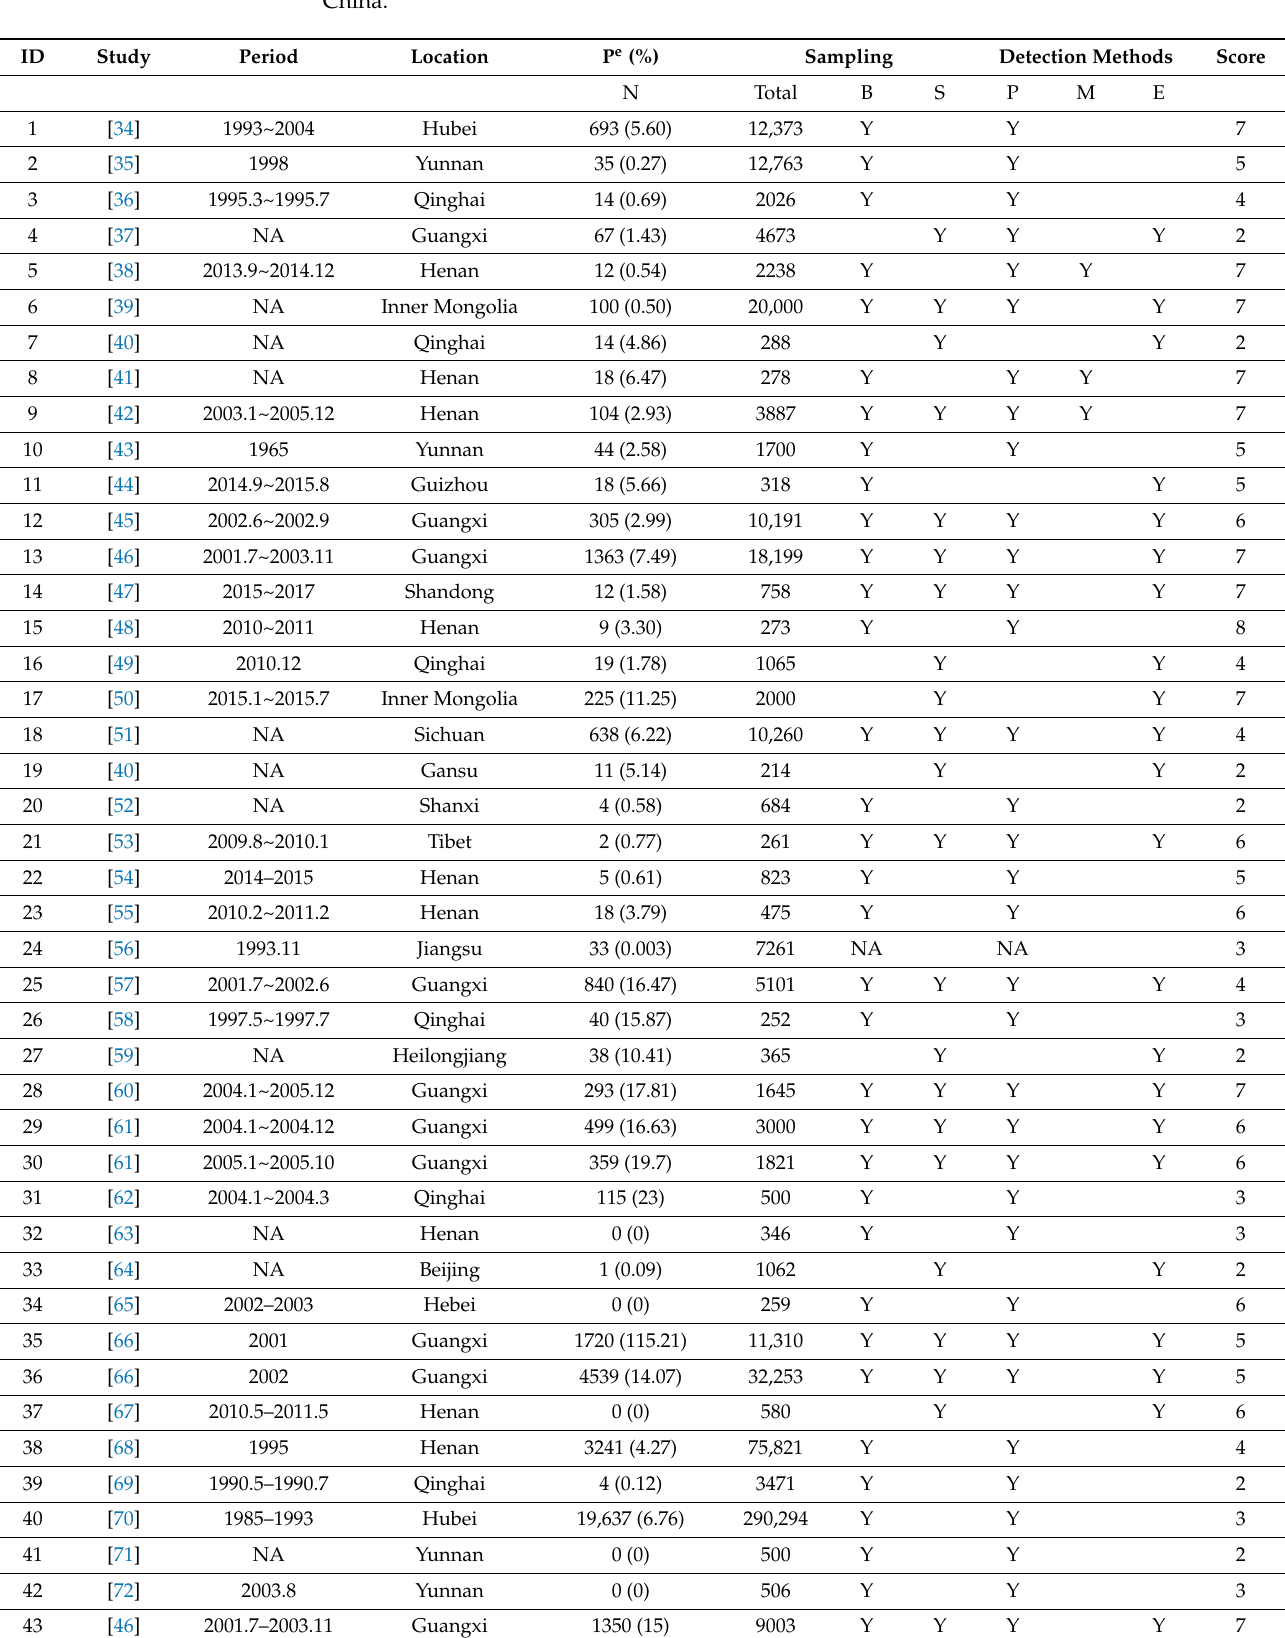
Table 1. Baseline characteristics of included studies of Trichinella spiralis infection in domestic pigs in